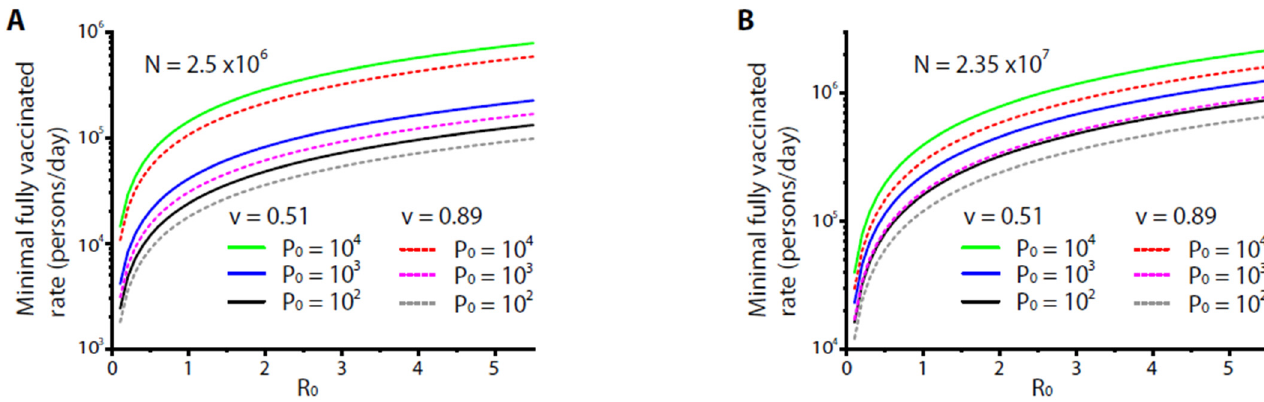
Figure 3. The numerical results from Equation (6) for two different population sizes of N (=2.5 × 10 6 in ( A ) and 2.35 × 10 7 in ( B )) and various initial carrier numbers P 0 . For all the results, the average infectious period T i was set as 14 days. v = 0.51 or 0.89 was the effectiveness of the vaccine.